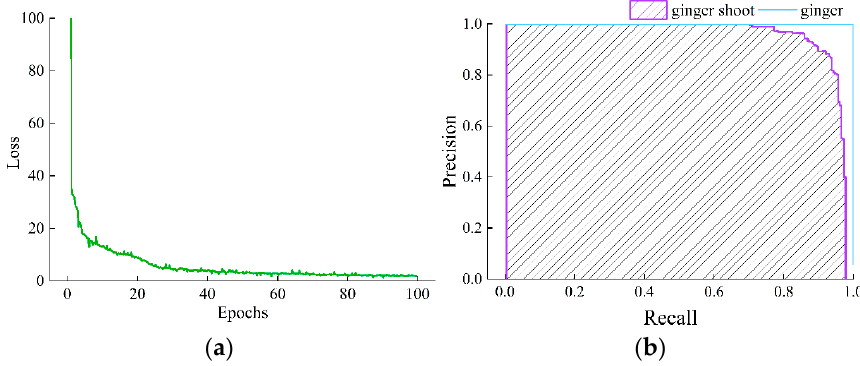
Figure 8. Loss curve and P-R curve comparison chart. ( a ) Loss curve; ( b ) P-R curve.